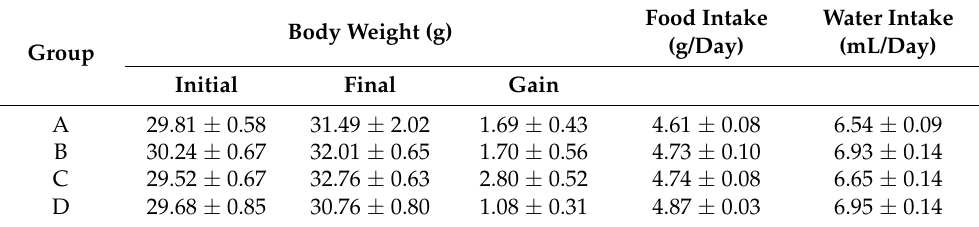
Table 1. Effects of SPE treatment on body weight, food intake, and water intake in male SAMP8 mice.